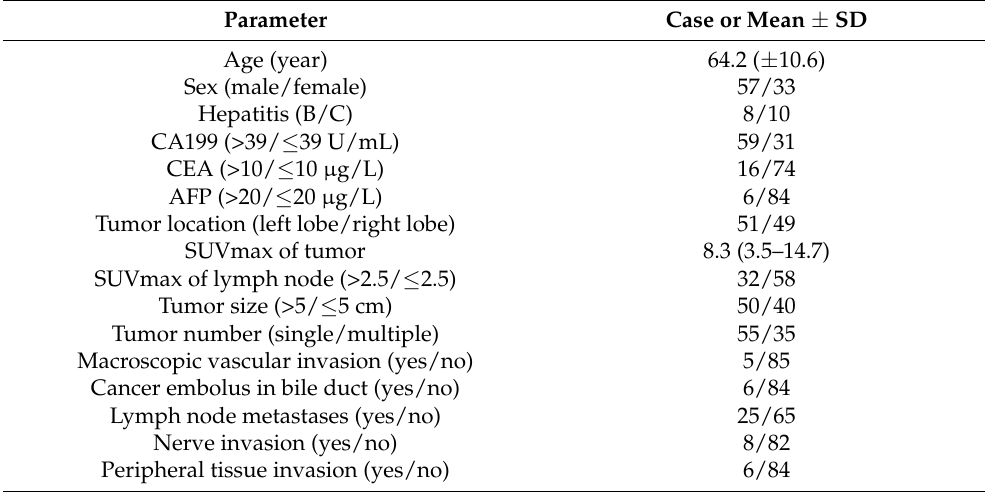
Table 1. Clinical and histopathologic characteristics of patients undergoing surgery (n = 90). Parameter